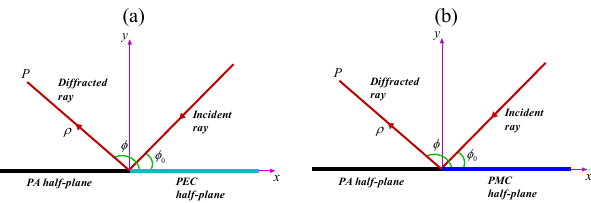
FIGURE 2. The diffraction geometry a) by a planar junction between PEC and PA half-planes, b) by a planar junction between PMC and PA half-